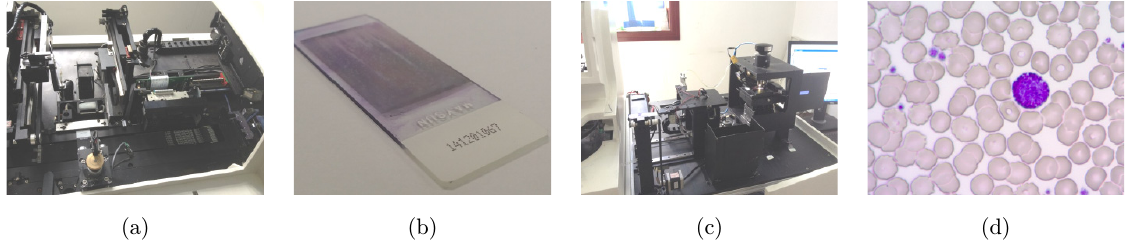
Fig. 1. The online blood smear automatic microscopic image detection construction. (a) Blood smear producing part, (b) blood smears, (c) image capturing part and (d) microscopic image captured.